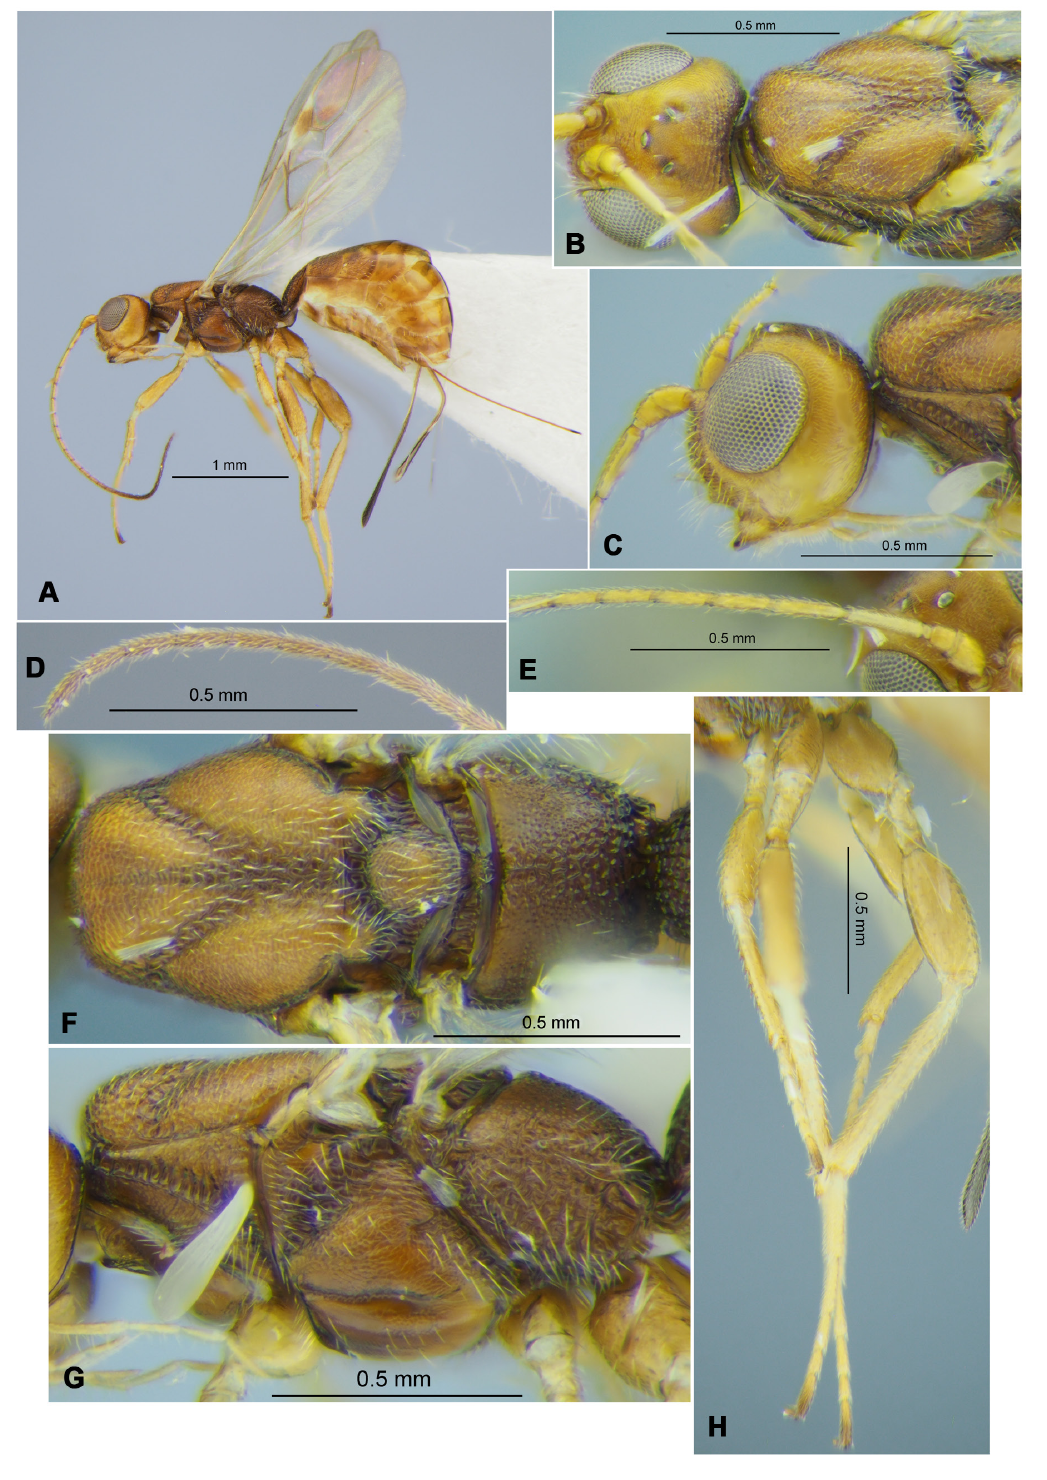
Fig. 1. Dendrosotinus ( Dendrosotinus ) ferrugineus (Marshall, 1888), ♀ (RMNH). A . Habitus, lateral view. B . Head and mesoscutum, dorsal view. C . Head and mesoscutum, lateral view. D . Apical segments of antenna. E . Basal segments of antenna. F . Mesosoma, dorsal view. G . Mesosoma, lateral view. H . Hind